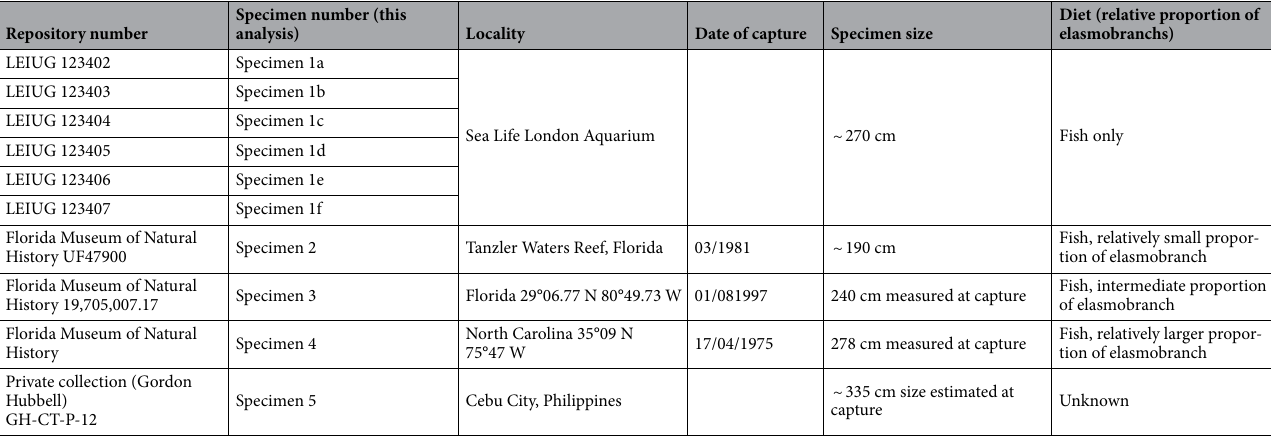
Table 4. Specimens of Carcharias taurus from which tooth texture data were obtained. Dietary preferences for specimens 2–4 were inferred from published analyses 30–32 demonstrating that in wild populations of the Western Atlantic 31,32 larger C. taurus consume more elasmobranchs than smaller individuals (< 2 m total